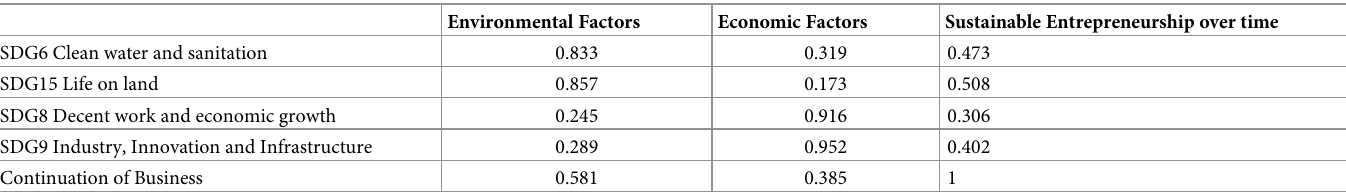
Table 4. Discriminant validity. Cross loadings analysis.